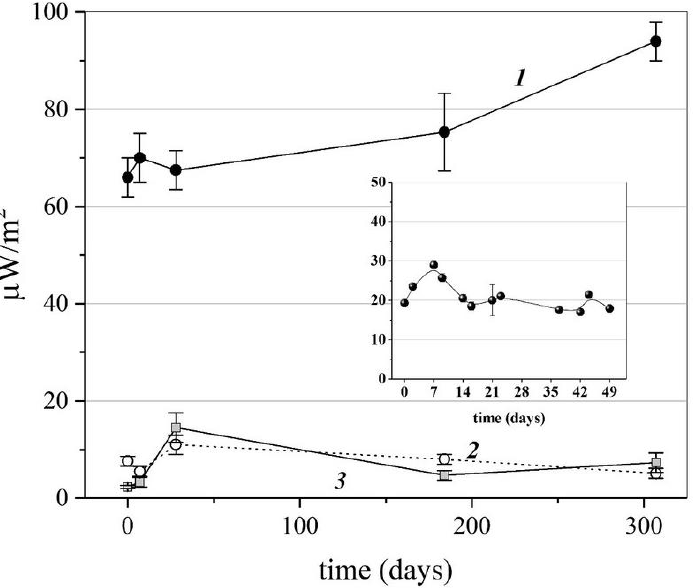
Figure 3. Time stability of thermal radio emission during heat activation of the AINF-γ preparation (t = 37 °C, Curve 1) and light activation of SARS-CoV-2 VLP (λ = 412 nm, see the inset). Curves 2 and 3–thermal radio emission of lactose powder and placebo to the AINF-γ drug preparation, respec- tively.